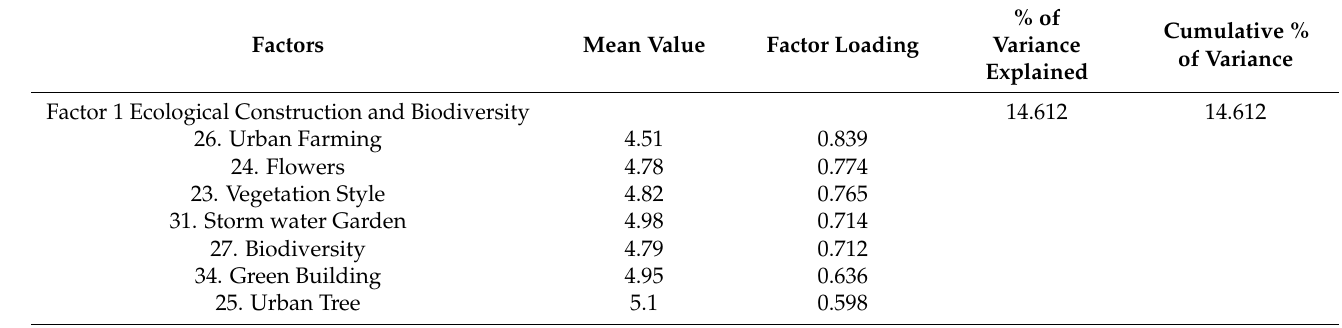
Table 2. Mean values, factor loading, percentage of variance explained, and cumulative percentage of the variance of all